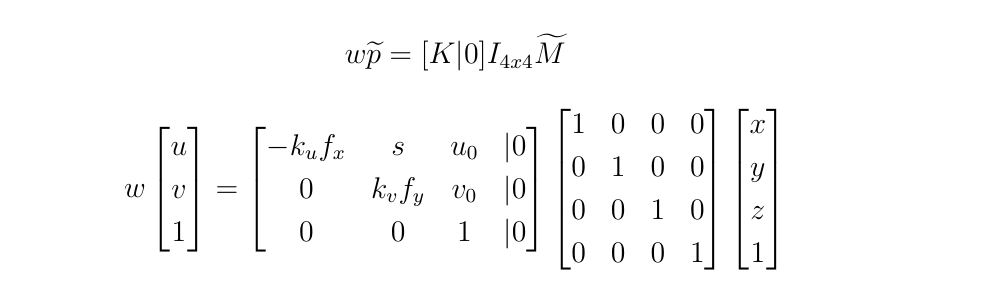
Figure 1. Sensors system geometry: R respectively. Polar coordinates m not the elevation angle. The light ray L and the projected point p in the image I together with the horizontal radar